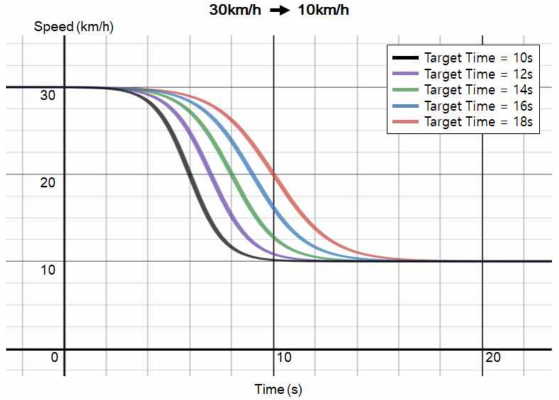
Figure 7. Proposed deceleration model. Speed graph showing time taken to reach target speed. Plotted by using k from Equation (5). The tanh function controls vehicle